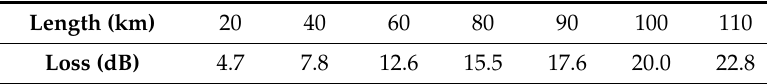
Table 3. Fiber loss characterization.